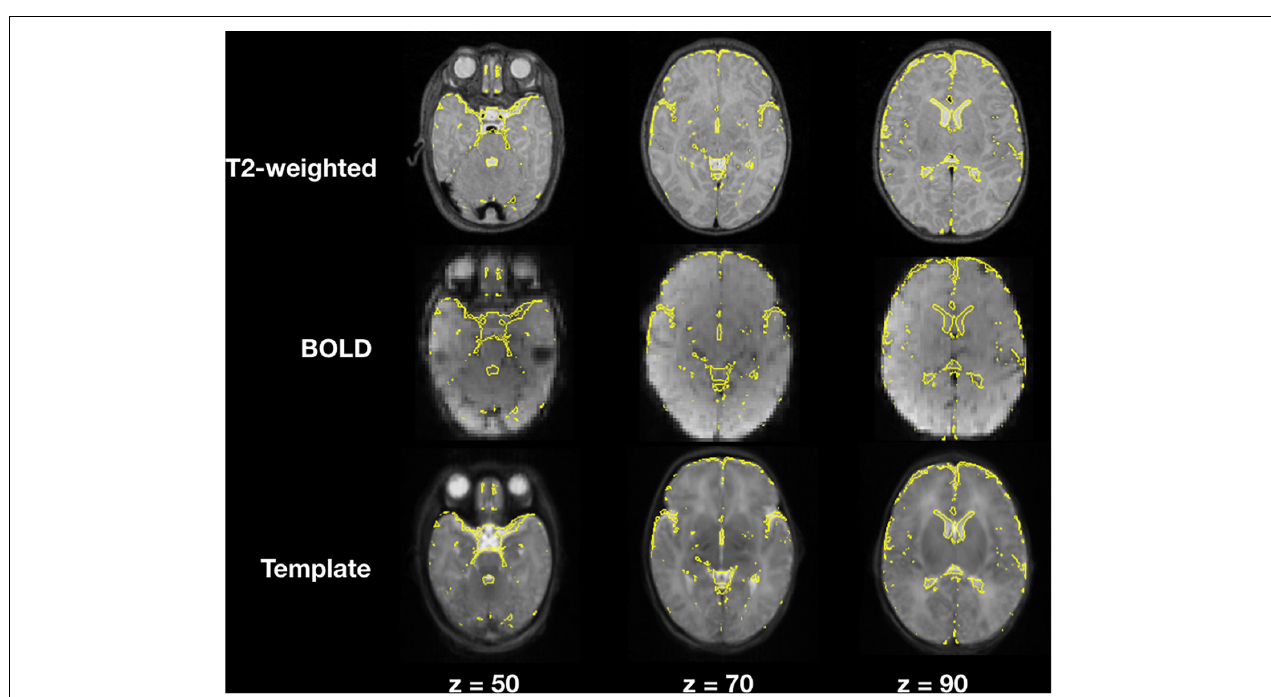
FIGURE 4 | T2-weighted and BOLD image registration to stereotaxic space. Gray scale images represent the T2-weighted, average BOLD and template images; the yellow lines correspond to the cerebrospinal fluid contours obtained from the T2-weighted image segmentations.